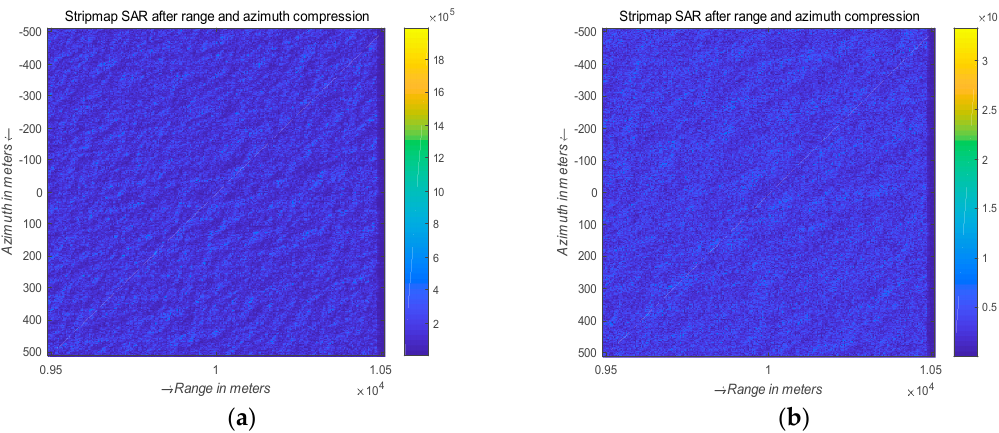
Figure 6. Ocean surface synthetic aperture radar (SAR) images as follows: ( a ) wind speed of 10 m/s and ( b ) wind speed of 15 m/s.